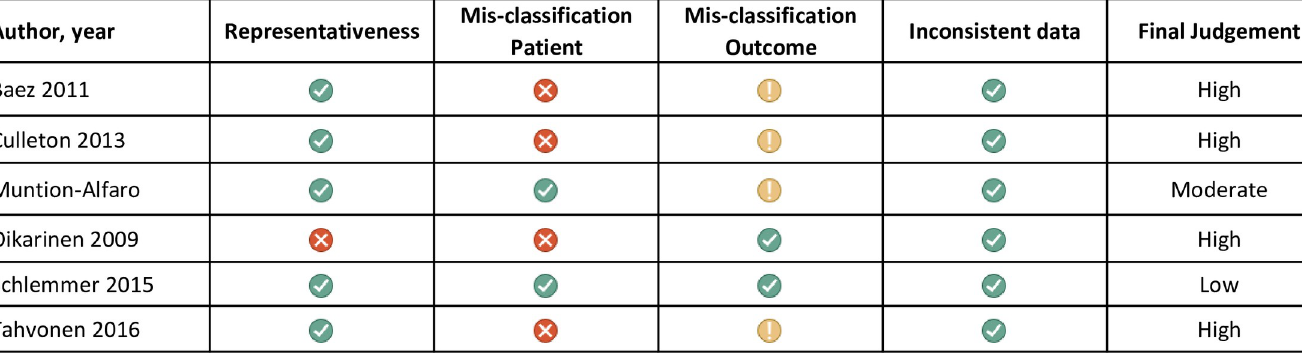
Fig 2. Risk of bias of included studies as determined by the representativeness of patients, risk of misclassification of patients, misclassification of the outcome of interest, and inconsistent data.